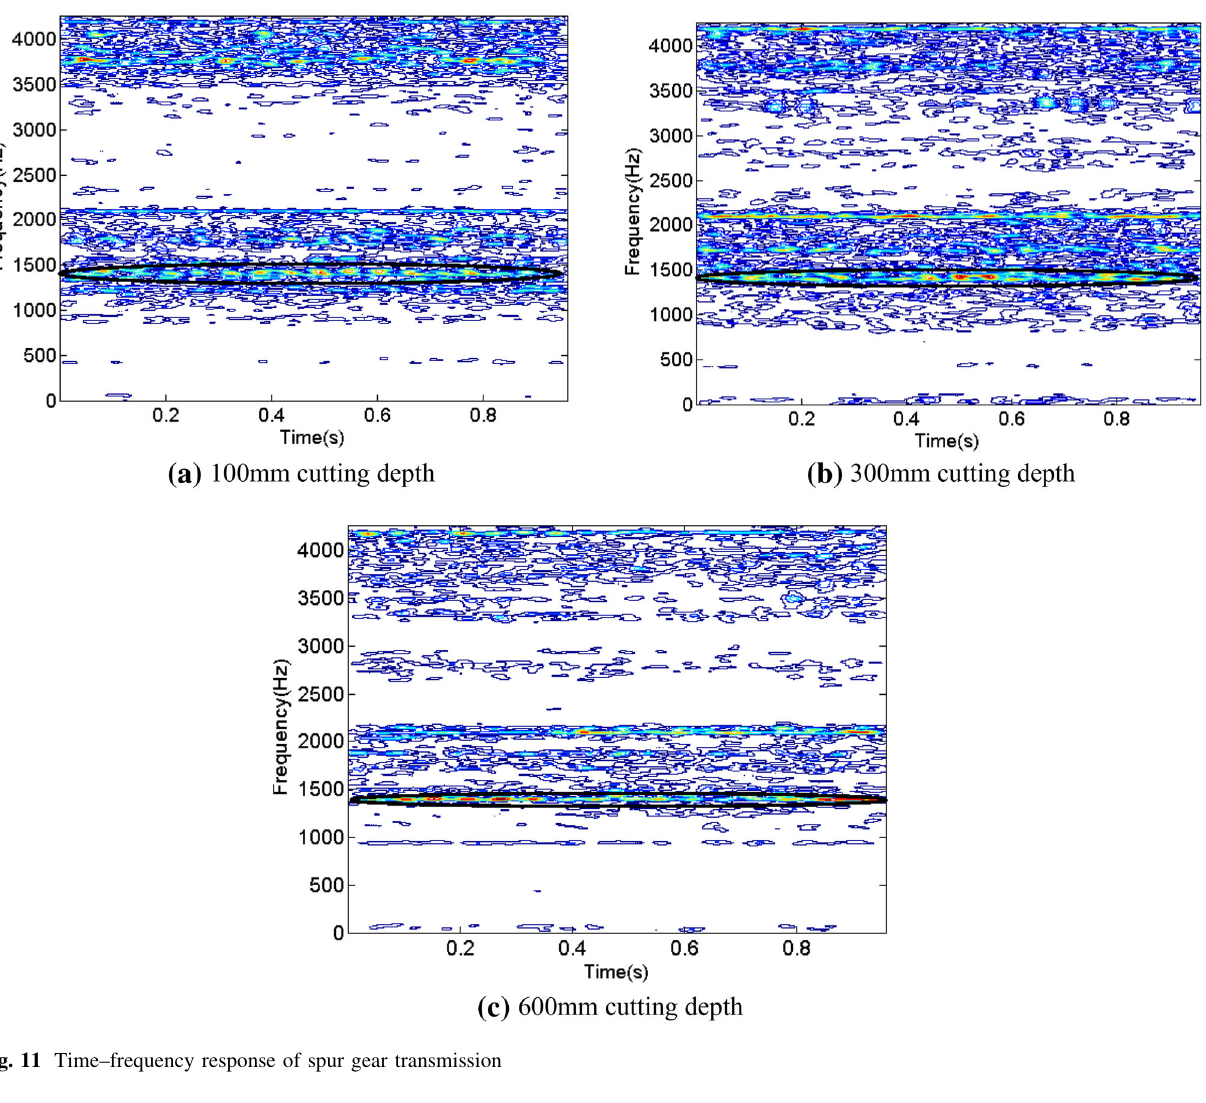
Fig. 11 Time–frequency response of spur gear transmission